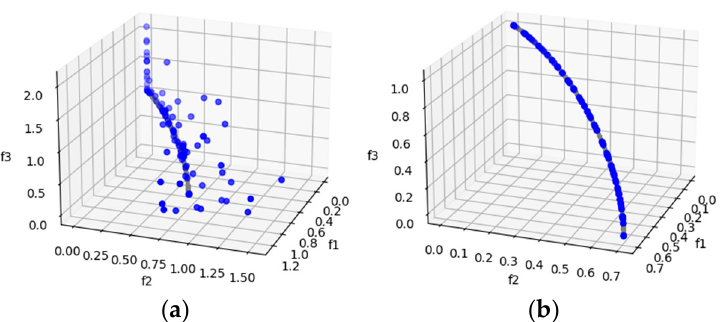
Figure 6. The plots of the approximate PFs with the highest HV value against real PF. ( a ) DTLZ5 approximate PF using MOSA/D-CGO; ( b ) DTLZ5 approximate PF using MOSA/D-DE.